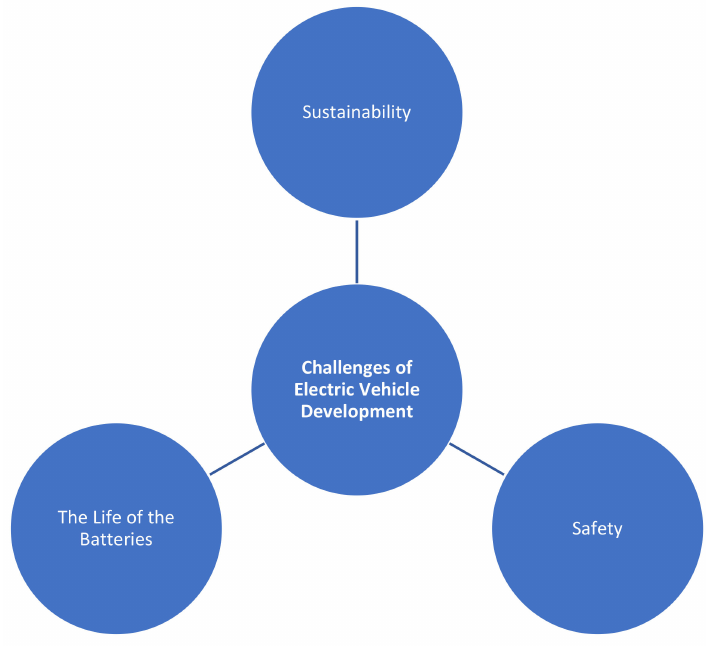
Figure 3. Challenges of Electric Vehicle